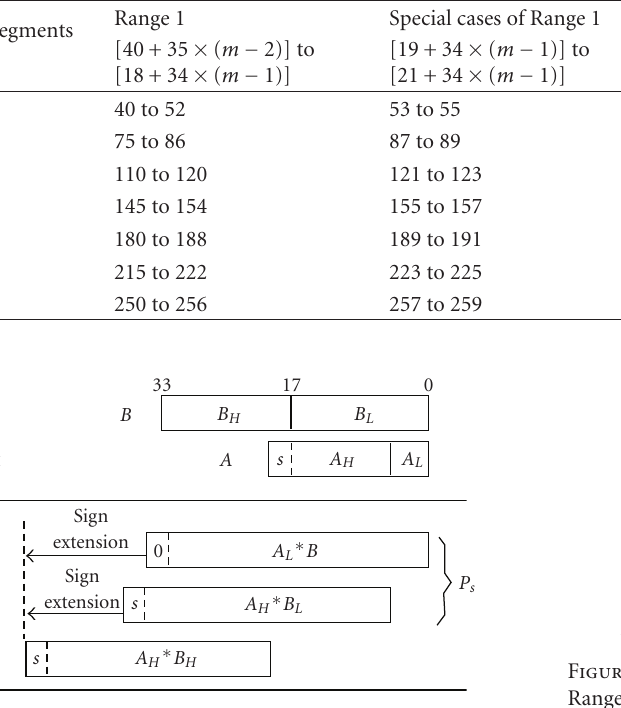
Figure 6: Generation of the partial product for the special case of Range 1.